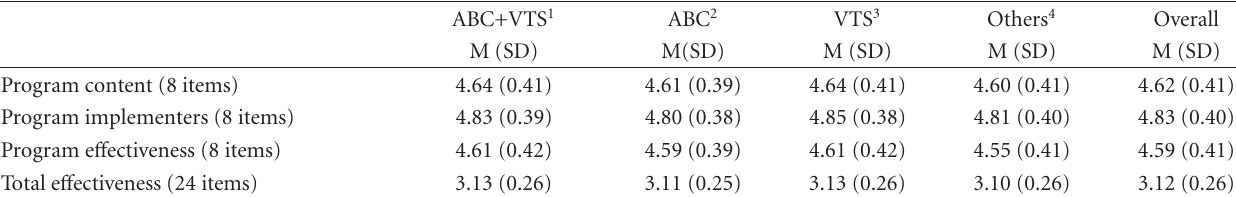
Table 9: Means and standard deviations among the variables by program